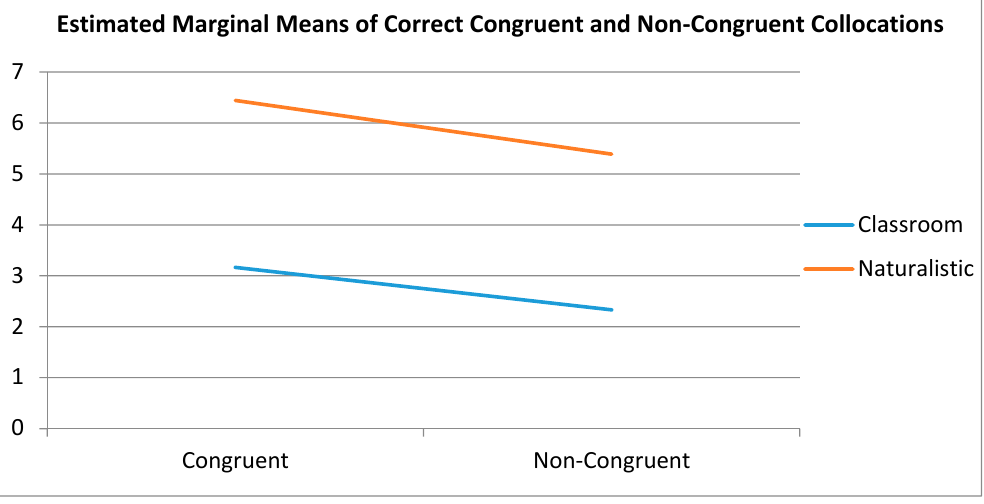
Figure 2. The Correct Answers of Classroom and Naturalistic Groups on Congruent and Non-Congruent Collocations.